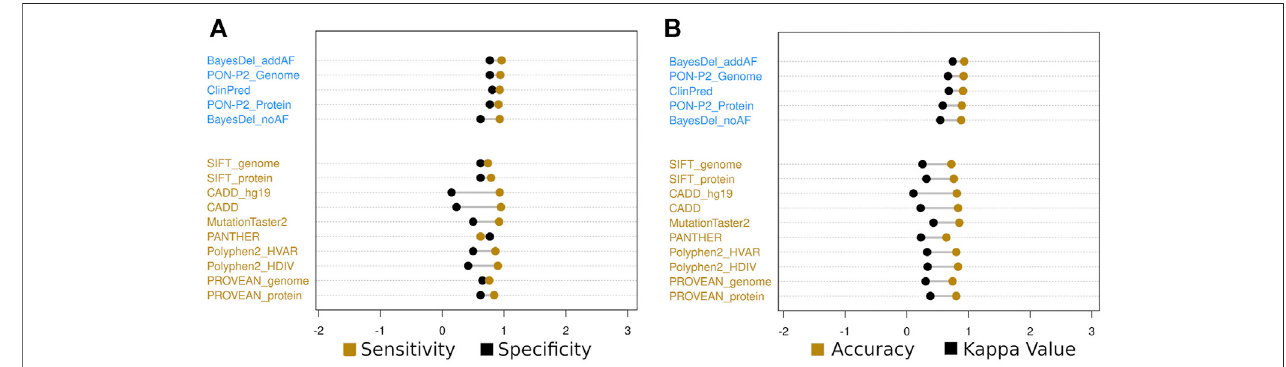
FIGURE 3 | Sensitivity and speci fi city (A) and accuracy and kappa value (B) of the top fi ve classi fi ers in blue (BayesDel-addAF, PON-P2-genome, ClinPred, PON- P2-protein, and BayesDel-noAF algorithms) and the top six cited in yellow (SIFT, CADD, MutationTaster2, PANTHER, PolyPhen2, and PROVEAN) for the less stringent criteria